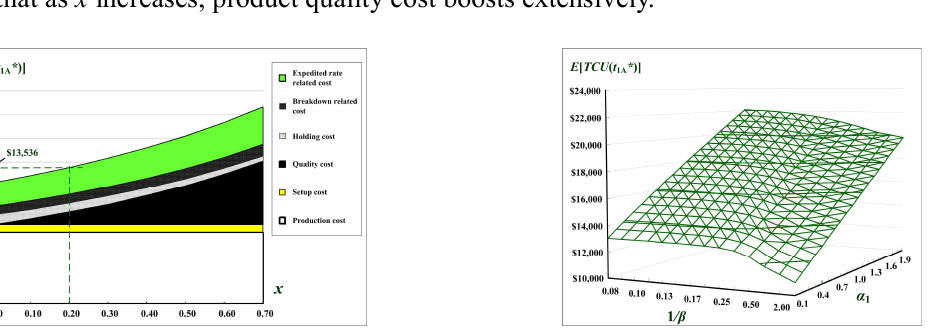
Fig. 15. Combined influence of variations in 1/ β and factor of expedited rate α 1 on E [ TCU ( t 1A